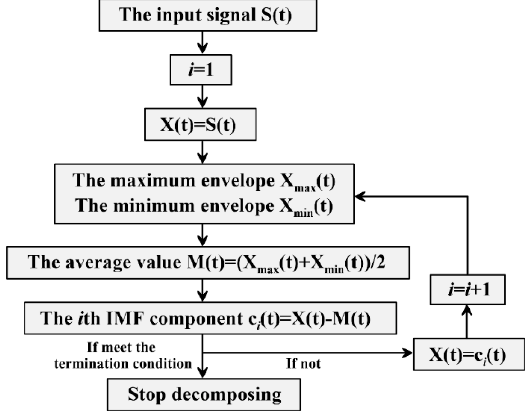
Figure 3. The decomposition flowchart of empirical mode decomposition (EMD).